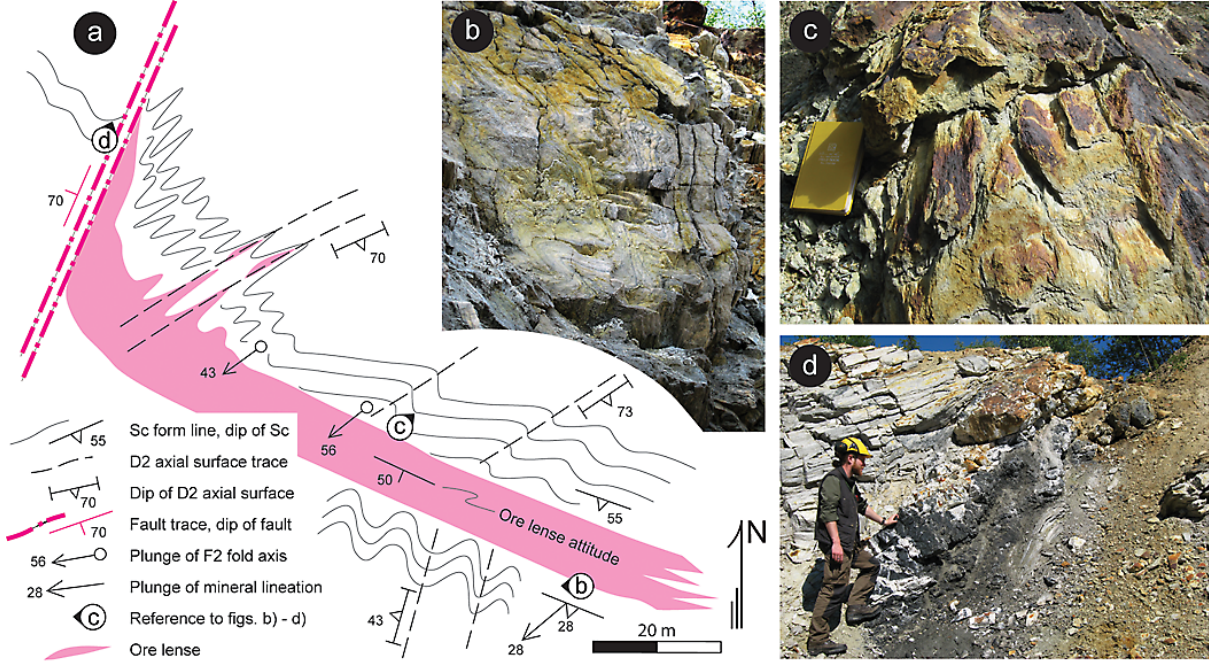
Fig. 9. Structures in the A4 open pit, see Fig. 2a for location. (a) Geological overview of the A4 open pit. (b) Plunging inclined F2 folds in the sericite-altered stratigraphic hanging wall to the A4 ore lens. Vertical section, view towards W. Width of view approximately 2m. (c) Plunging upright F2 folds in the stockwork-system mineralization in the stratigraphic footwall to the A4 ore lens. View up-plunge along the fold axes, towards NE. Width of view approximately 80cm. (d) A semi-brittle WNW-dipping high-strain zone constraining the western extent of the A4 ore lens. Vertical section, view towards